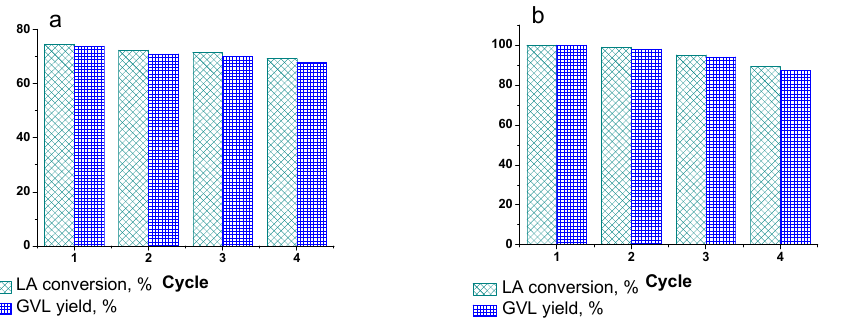
Figure 9. Recycling experiments for Ru-PPP ( a ) and Ru-PPP-S ( b ) in LA hydrogenation. Reaction conditions are: 130 ◦ C, 2 MPa, 0.016 mol.% Ru, 4 h for Ru-PPP and 100 ◦ C, 2 MPa, 0.064 mol.% Ru, conditions are: 130 °C, 2 MPa, 0.016 mol.% Ru, 4 h for Ru-PPP and 100 °C, 2 MPa, 0.064 mol.% Ru, 4 h for Ru-PPP-S. 4 h for